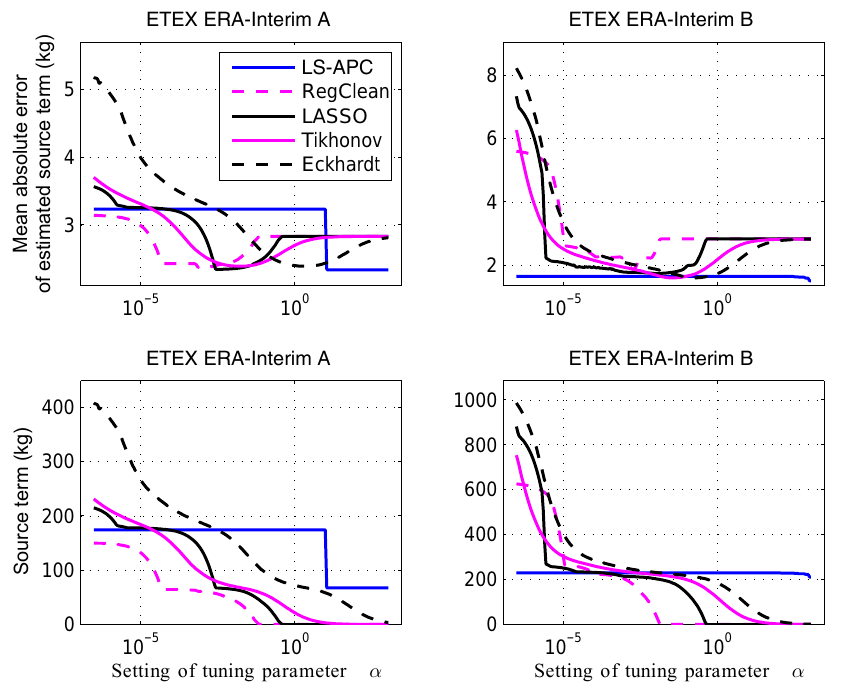
Figure 6. Comparison of sensitivity of the tested algorithms to the setting of the selected tuning parameter α measured in terms of the mean absolute error metric (top row), Eq. (26), and total estimated mass of the source term (bottom row) on data ETEX ERA-Interim A and